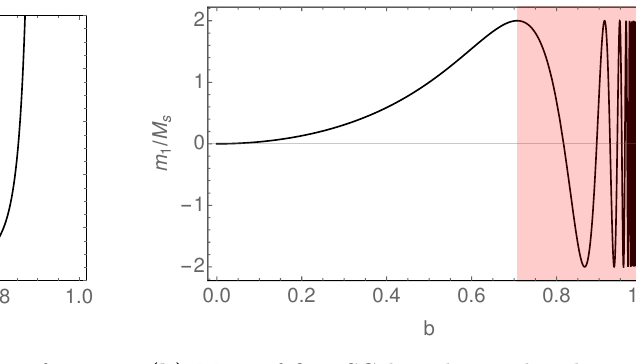
(b) Mass of first SG breather vs b . The non- tion of b . physical region is highlighted in red. Figure 3. Masses in the sine-Gordon